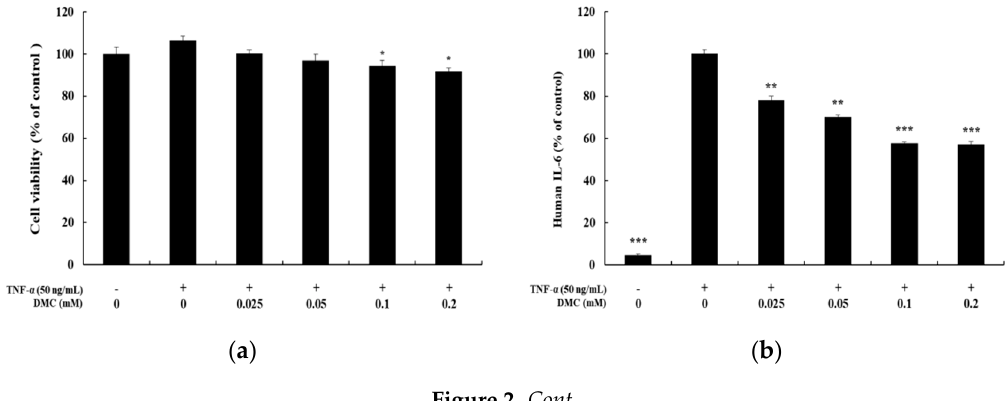
Figure 1. Effect of 7,8-dimethoxycoumarin (DMC) on the viability of HaCaT cells. ( a ) Structures of 7,8-dimethoxycoumarin. ( b ) Cells were treated with DMC (0.025, 0.05, 0.1, 0.2, and 0.4 mM) for 20 h. Data are presented as mean ± standard deviation (SD) of at least four independent experiments (n = 4). * p < 0.05, *** p < 0.001 vs.